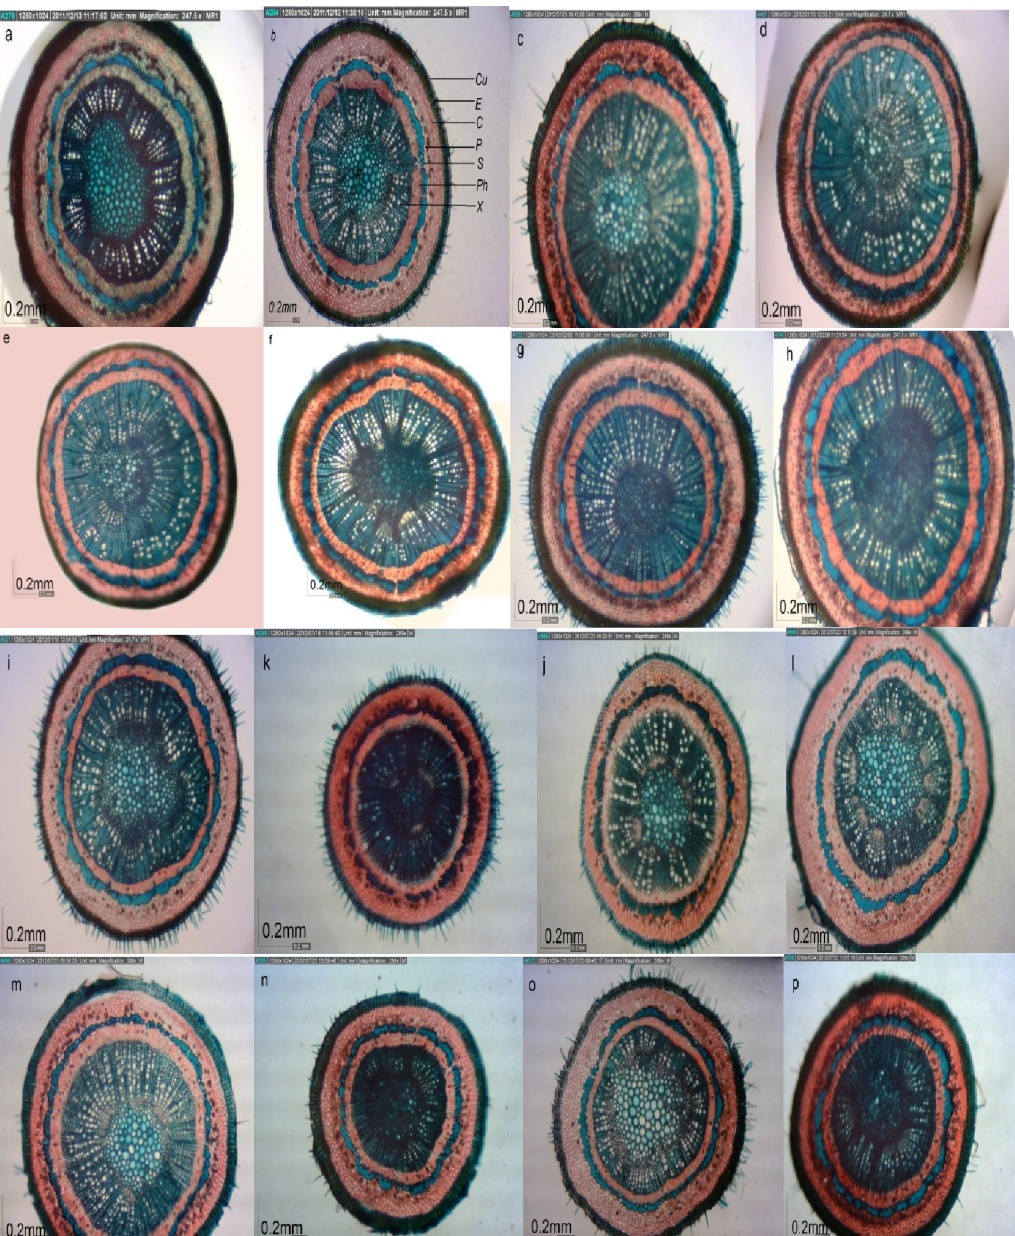
Fig. 4. Stem cross sections in the populations of C. orientalis: a, Abshar; b, Gheji; c, Kanigandi; d, Kiasar (1000m a.s.l); e,Kiasar (1400m a.s.l); f, Rasht (1600m a.s.l); g, Rasht (1800m a.s.l); h, Tangeh Gol; I, Tangrah; j, Qozlogh (1100m a.s.l); k, Qozlogh (1300m a.s.l); l, Zaringol; m, Mohammad Abad; n, Parand (904 m a.s.l); O, Parand (805m a.s.l); P, Chelav, Cu – cuticle; E – epidermis; P – parenchyma; C- collenchymas; S – sclerenchyma; PH – phloem; X- xylem; Pi –